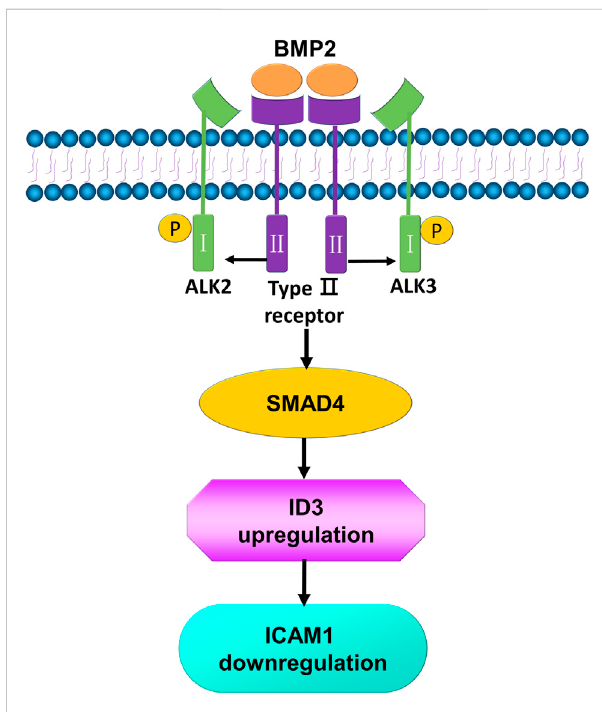
FIGURE 10 Schematic diagram of the proposed molecular mechanisms by which BMP2 downregulates the expression of ICAM1 in human endometrial stromal cells and decidual cells. BMP2 binds to a pair of ALK3 type 1 receptor and BMP type II receptors, leading to the activation of canonical R-SMADs, which are associated with a common SMAD (SMAD4) and further increases the transcription of ID3. The increase in ID3 suppresses the expression of